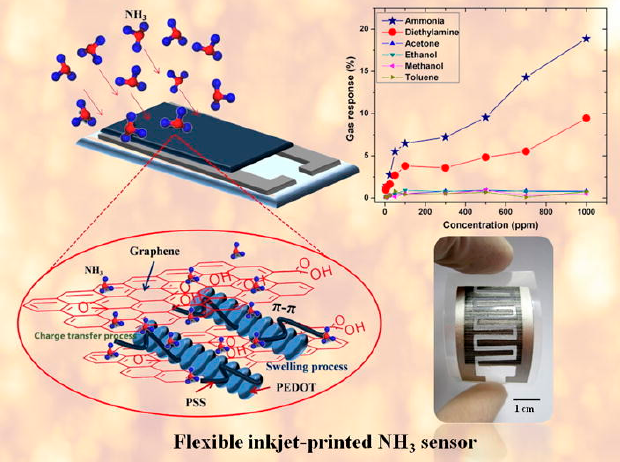
Figure 3. Flexible inkjet-printed GO/ PEDOT:PSS composite-based gas sensor for NH 3 detection [84]. Reproduced with permission from Elsevier.